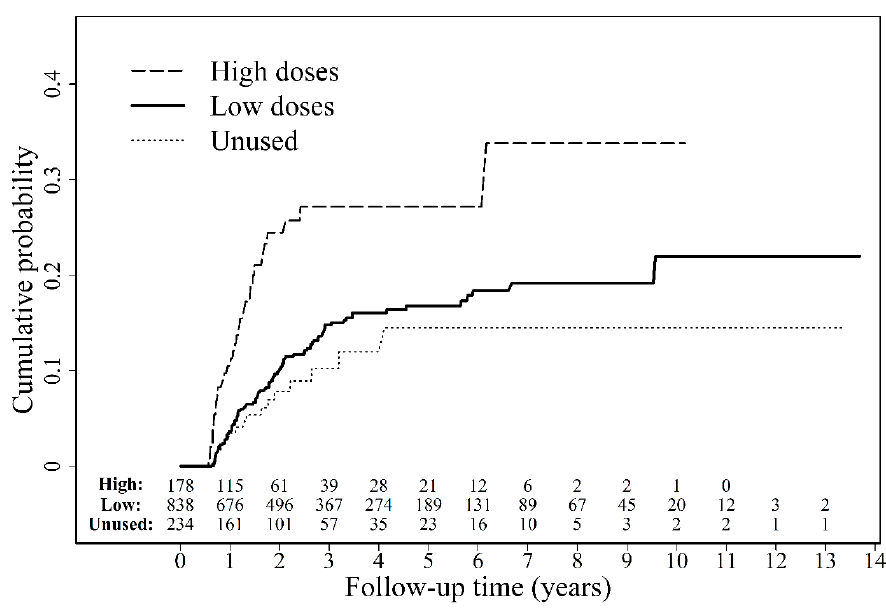
Figure 4. Effects of hepatocellular carcinoma recurrence on mortality of liver transplant recipients. HR, hazard ratio; CI, confidence interval. Table 4. Effects of Hepatocellular Carcinoma Recurrence on Mortality of Liver Transplant Recipients.